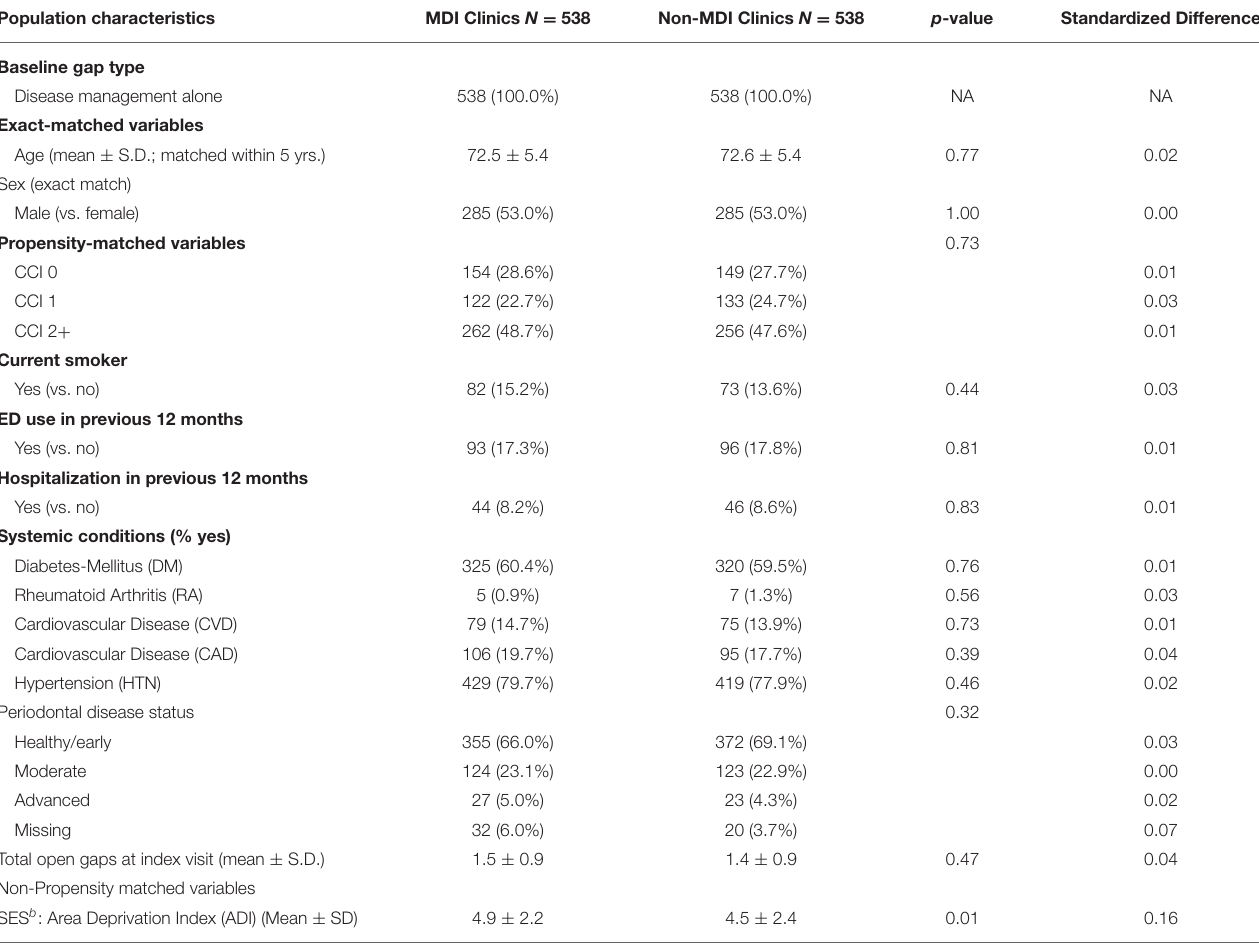
TABLE 1.2 | Population Characteristics: Disease Management Gaps Only. Population